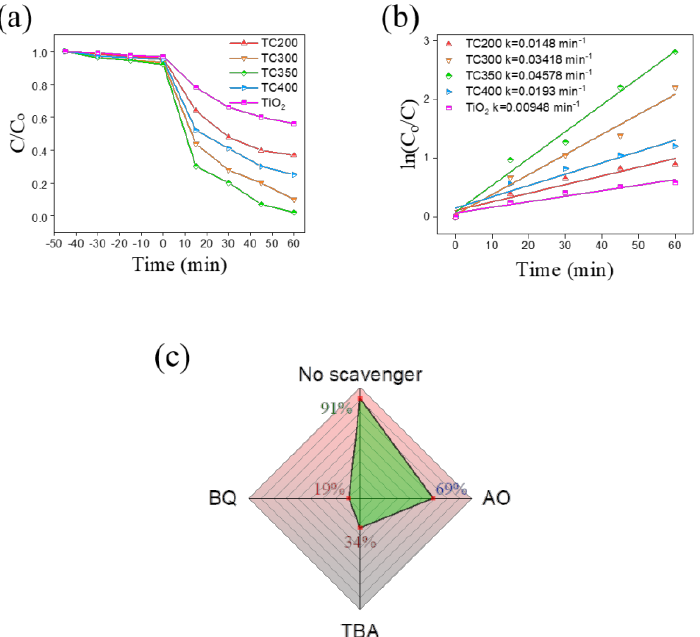
Figure 11. ( a ) C/Co vs. irradiation duration plots; ( b ) ln (Co/C) vs. irradiation duration plots; ( c ) degradation percentages of RhB solution with TC350 in the presence of various scavengers.